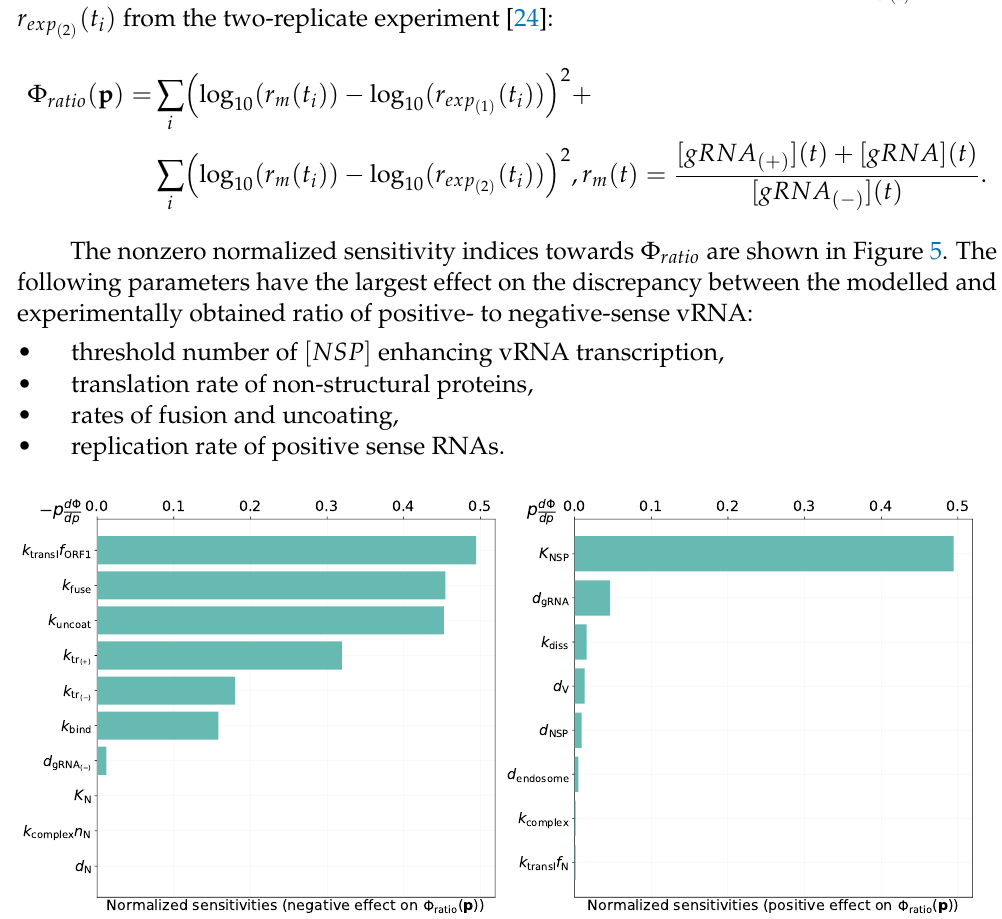
Figure 5. Local normalized sensitivity indices having negative ( left ) and positive ( right ) effects on the objective function Φ ratio ( p ) , i.e., on discrepancy between model and